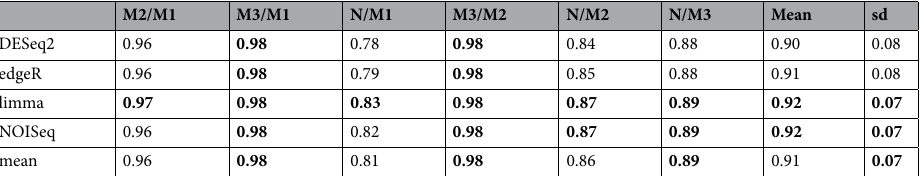
Table 2. Correlation between the estimated log2 fold change values from the differentially expressed gene detection methods and the known log2 fold change values for all spike-in sample comparisons, followed by the mean and standard deviation (sd) for each method. M1–3 refer to the samples with the corresponding mixes added; N refers to the sample to which no mix was added. The comparisons are shown such that n/m refers to comparison between n and m. For example, M2/M1 refers to the comparison between mix 2 and mix 1. Numbers in bold represente the highest values for each metric. Numbers in bold represente the highest values for each comparison.